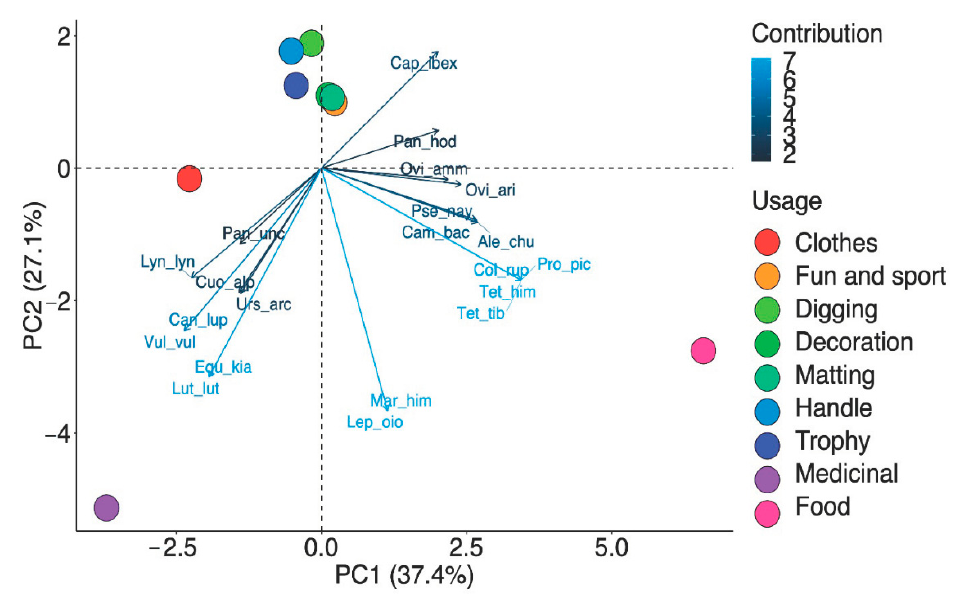
Figure 9. Principal Component Analyses (PCA) biplot of different provisioning services in Ladakh.